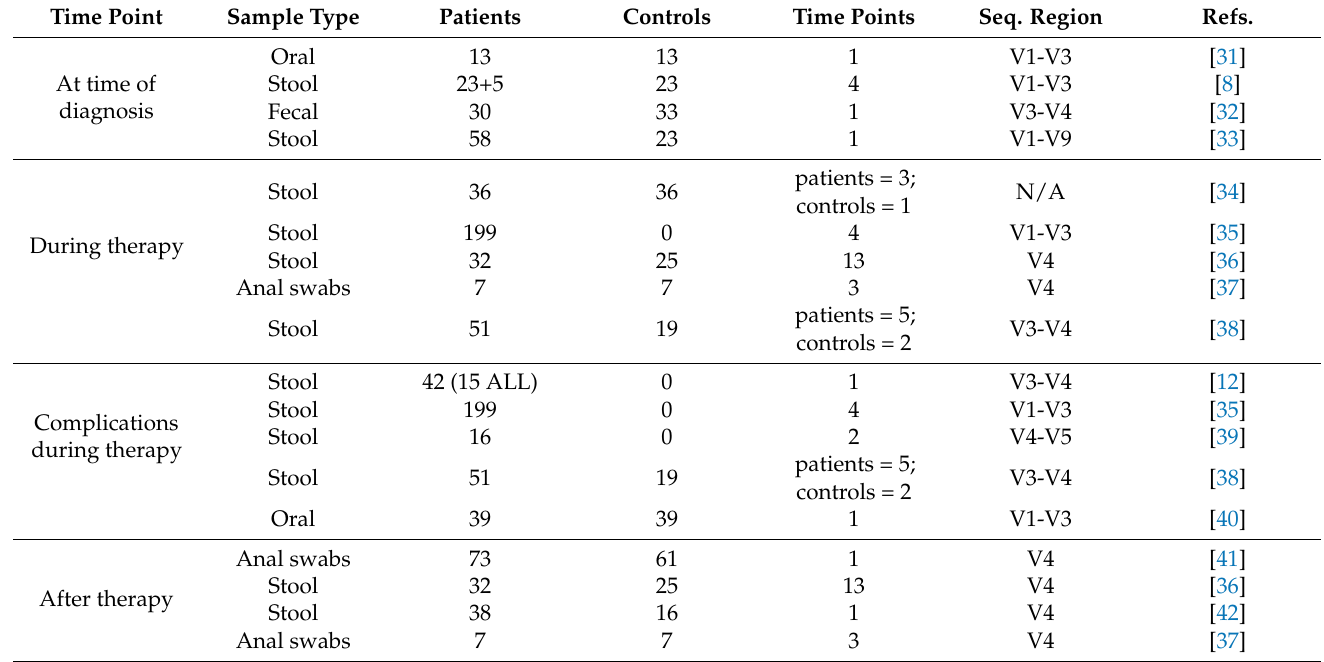
Table 2. Microbiome studies in pediatric ALL